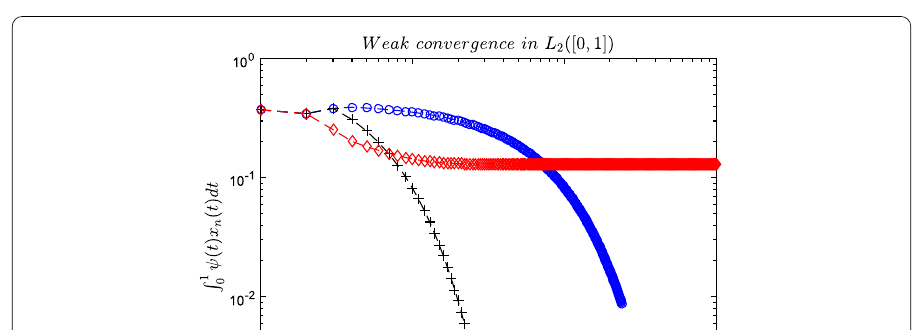
Figure 2 Example 1 with θ = 0.4 and λ n = 0.01 + (0.2) n –1